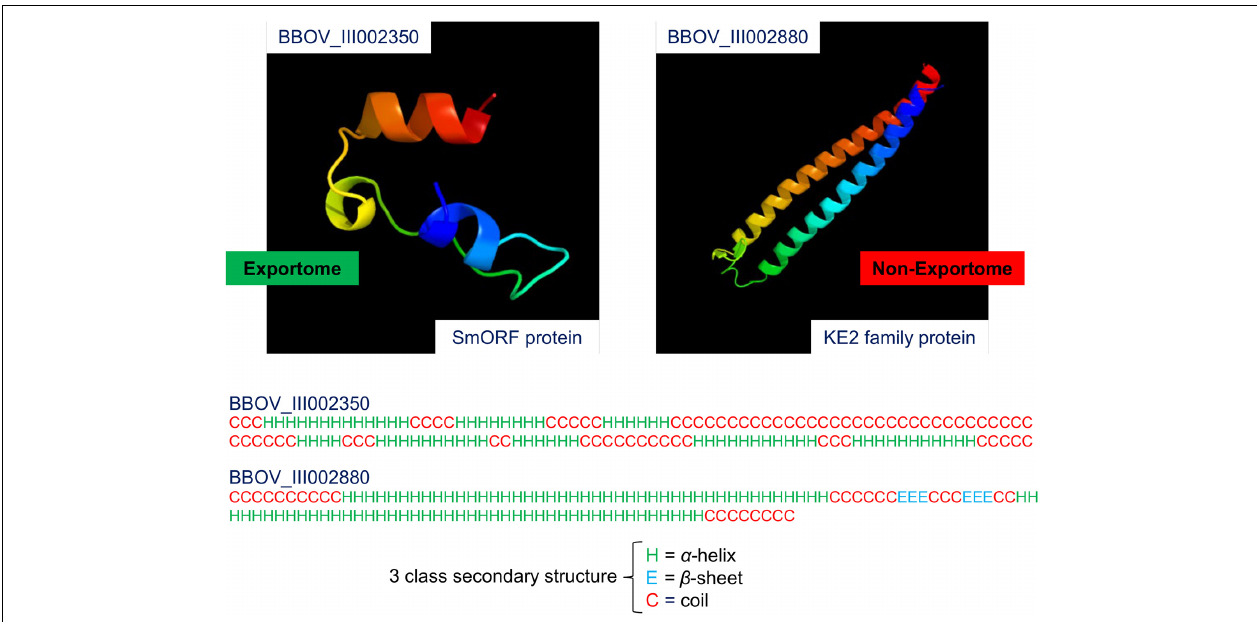
FIGURE 1 | 3D model of the secondary structure of two Babesia bovis T2Bo proteins. The two images were generated by the Phyre2 web portal for protein modelling, prediction and analysis. Protein folding is coloured by rainbow from the N to C Terminals. BBOV_III002350 is a small open reading frame (smORF) protein. It is expected to be an exportome member because smORF proteins are known to have an association with the erythrocyte membrane. BBOV_III002880 is a KE2 family protein. This protein is expected to be a non-exportome member because its subcellular location is in the cytoplasm. Note that the Phyre2 protein model reliability depends on the extent of homology between a user-supplied sequence and a sequence of known structure in the Protein Database (PDB). In this case, the BBOV_III002350 sequence has 23% coverage (33 out of 142 residues) with a known PDB molecule (nicotinate-nucleotide adenylyltransferase), and the BBOV_III002880 sequence has 83% coverage (101 out of 122 residues) with a PDB molecule (chaperone prefoldin subunit 4). Therefore, only the homologous residues are displayed in the images. Secondary-structure prediction for the three predominate states: α -helix, β -sheet, and coil are shown below the modelling images for the entire sequence lengths of BBOV_III002350 and